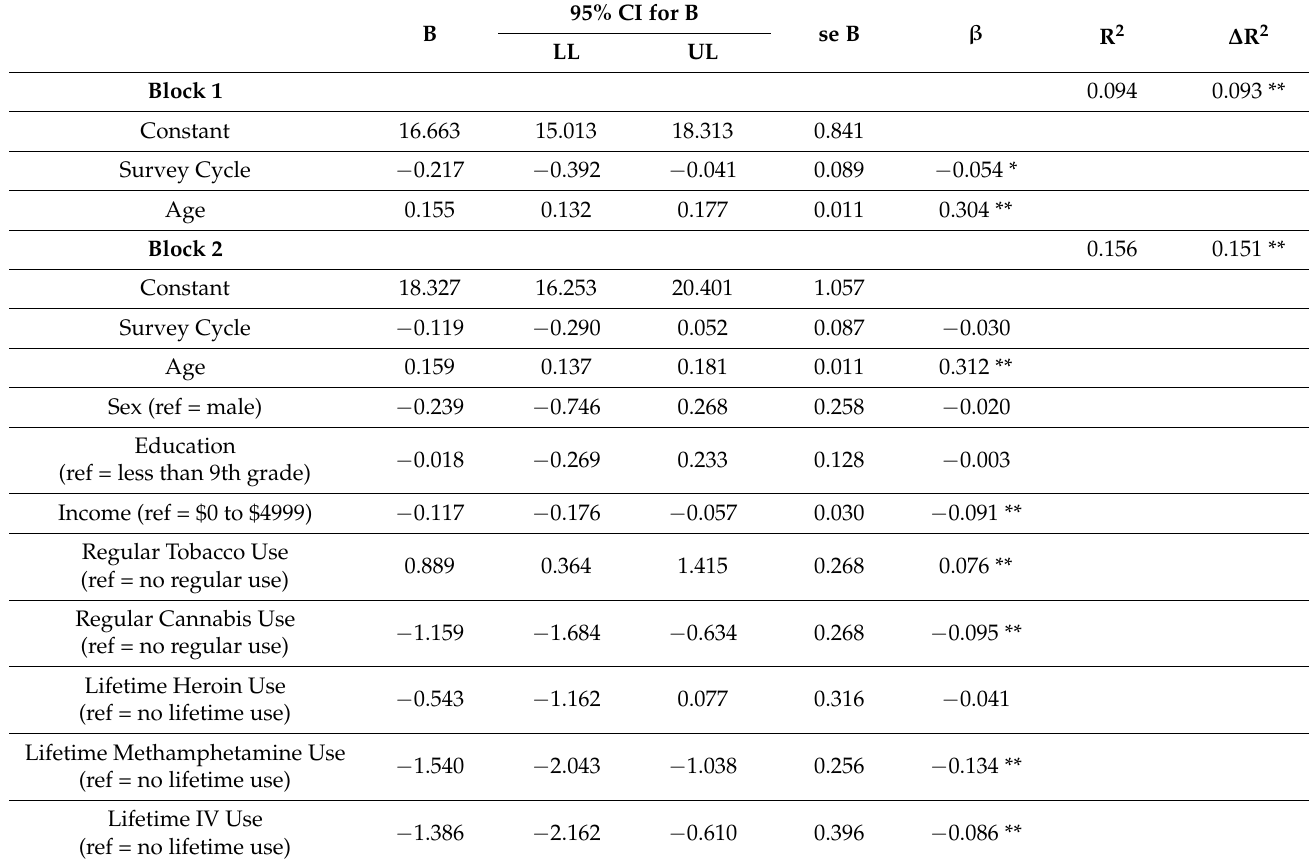
Table 3. Hierarchical multiple regression results for age of onset of cocaine use. 95% CI for B B se B β R